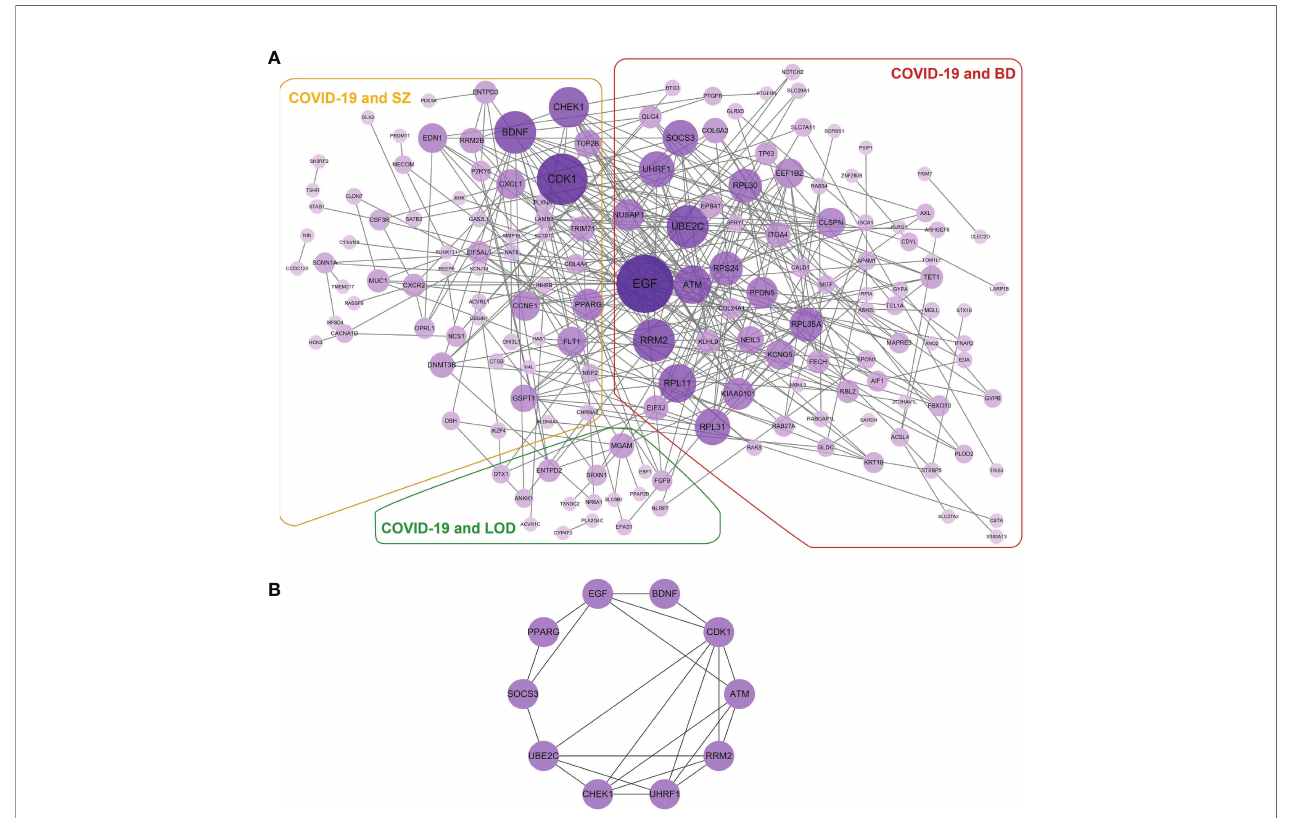
FIGURE 5 | (A) The detailed PPI network of shared DEGs in COVID-19 and psychiatric disorders. The purple circles illustrate the proteins common in COVID-19 and corresponding diseases. Nodes designate proteins and edges exhibit cross talk between two proteins. Proteins having multiple edges are overexpressed. (B) Hub protein network exhibits eight hub proteins based on the degree of cross talk. EGF has the highest cross talk with other